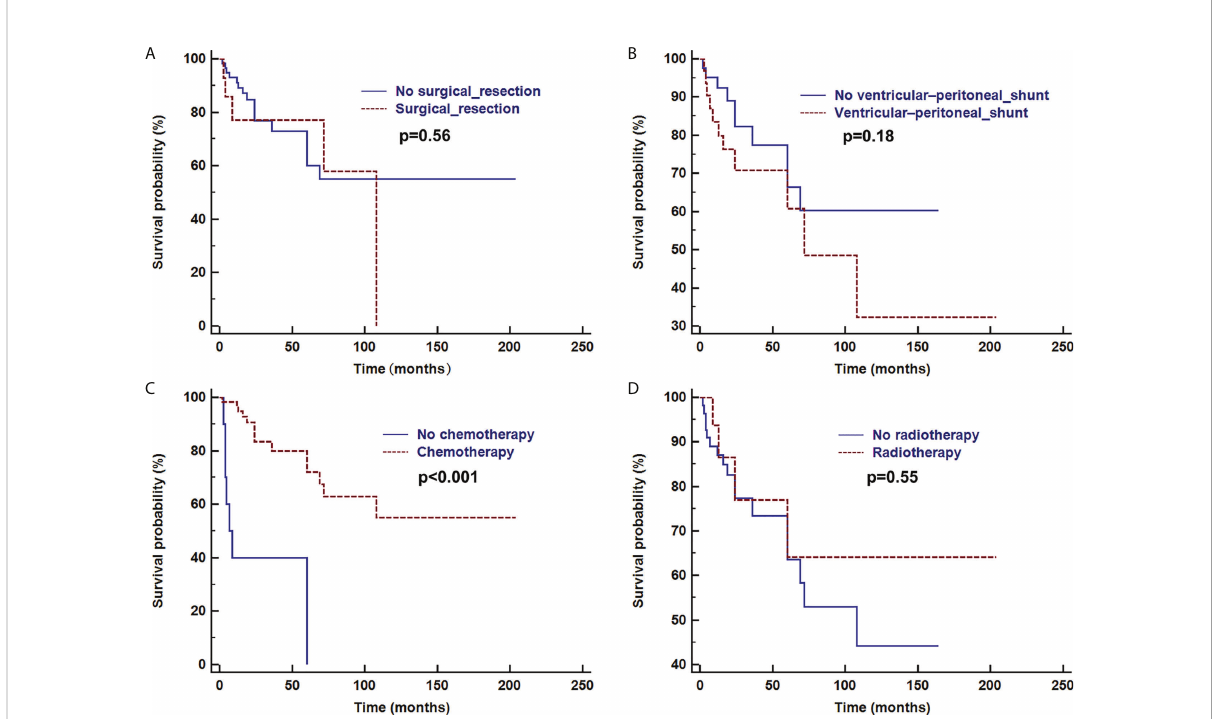
FIGURE 7 Survival curve analysis of treatment with or without surgical resection (A) , ventricular-peritoneal shunt (B) , chemotherapy (C) , and radiotherapy (D) were analyzed using Kaplan – Meier curves and log-rank